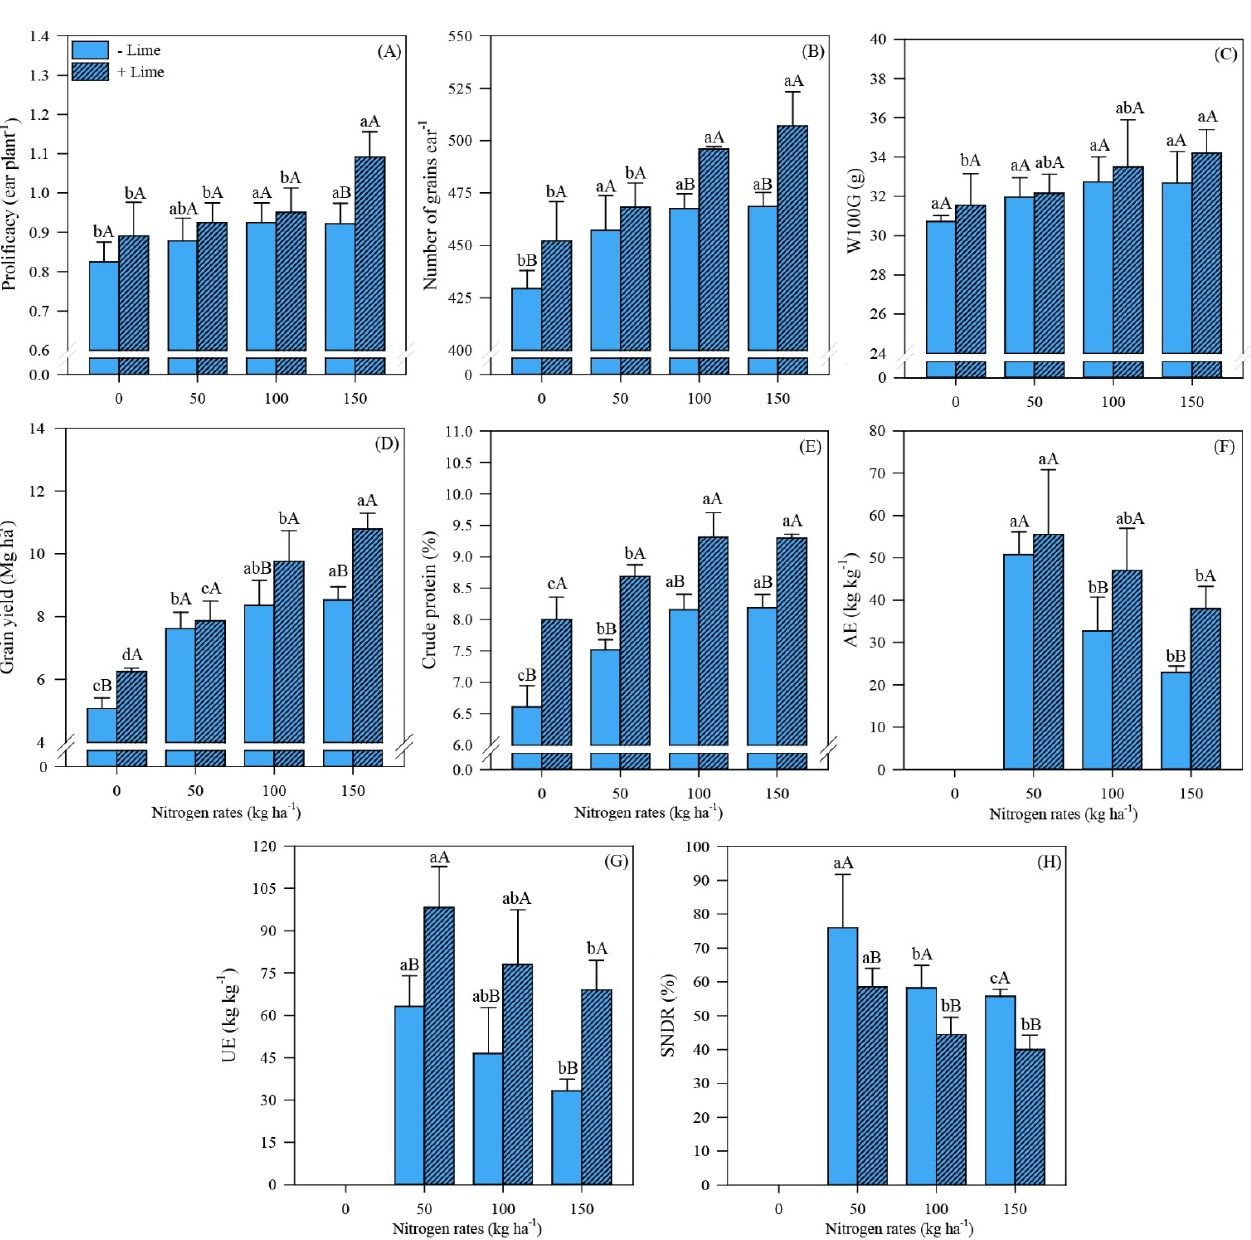
Figure 2. Prolificacy ( A ), number of grains per ear ( B ), 100-grain weight ( C ), grain yield ( D ), crude protein ( E ), agronomic efficiency ( F ), utilization efficiency ( G ), and soil N-dependent rate ( H ) of maize under different treatments (0 (no N applied), 50, 100, and 150 kg N · ha − 1 × absence ( − Lime) and presence (+Lime) of lime application). Different lowercase and uppercase letters indicate significant differences between N rates and lime applications, respectively, by Student’s t -test at p ≤ 0.05. The error bars express the standard error of the mean ( n =